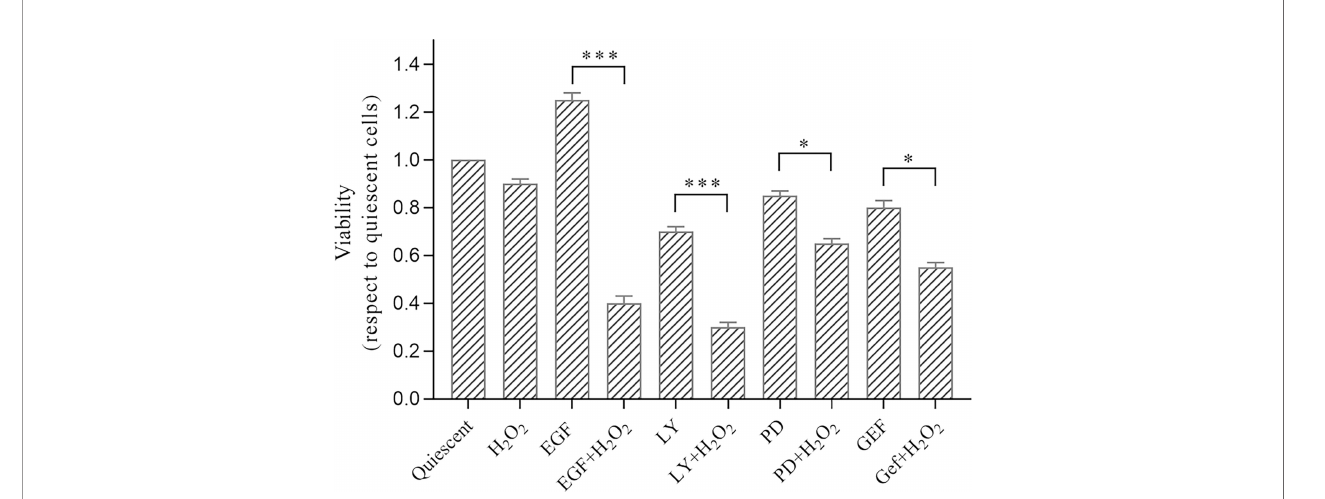
FIGURE 2 | Analysis of effects of treatments with H 2 O 2 combined with ErbB pathway inhibitors on AGS cell viability. Subcon fl uent cells were serum-starved overnight and treated with 50 ng/mL EGF, 1 m M ge fi tinib (GEF), 25 µM LY294002 (LY), 50 m M PD98059 (PD), and/or 50 m M H 2 O 2 or untreated (Quiescent). Cell proliferation (Viability) was evaluated after 24 h (MTS assay), with the data expressed normalized to quiescent cells. Data are means ± standard deviation of four independent experiments, each in quintuplicate. *p < 0.05; ***p < 0.001 (student ’ s